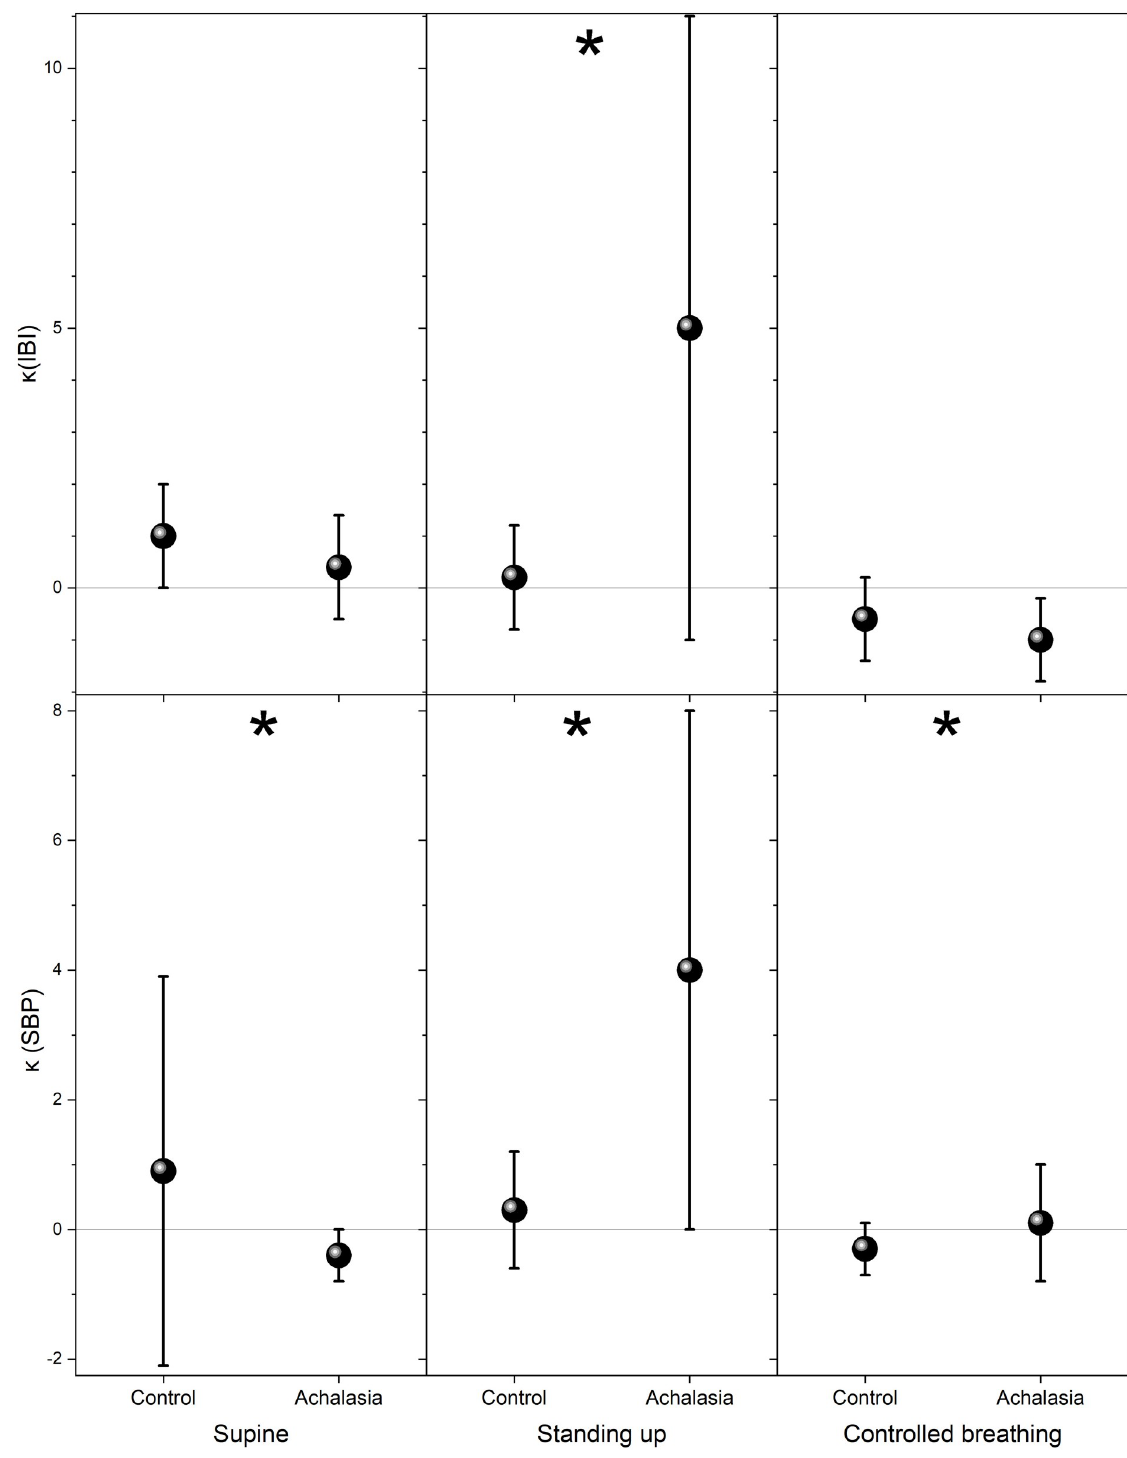
Fig 6. Kurtosis with respect to the median for control and achalasia groups during supine position (left-hand panels), standing up (middle panels), and controlled breathing (right-hand panels), IBI (top row) and SBP (bottom row). The vertical crosshair corresponds to one standard deviation around the population average, while the dot is the median; � indicates statistically significant difference with respect to control ( p value < 0.05).